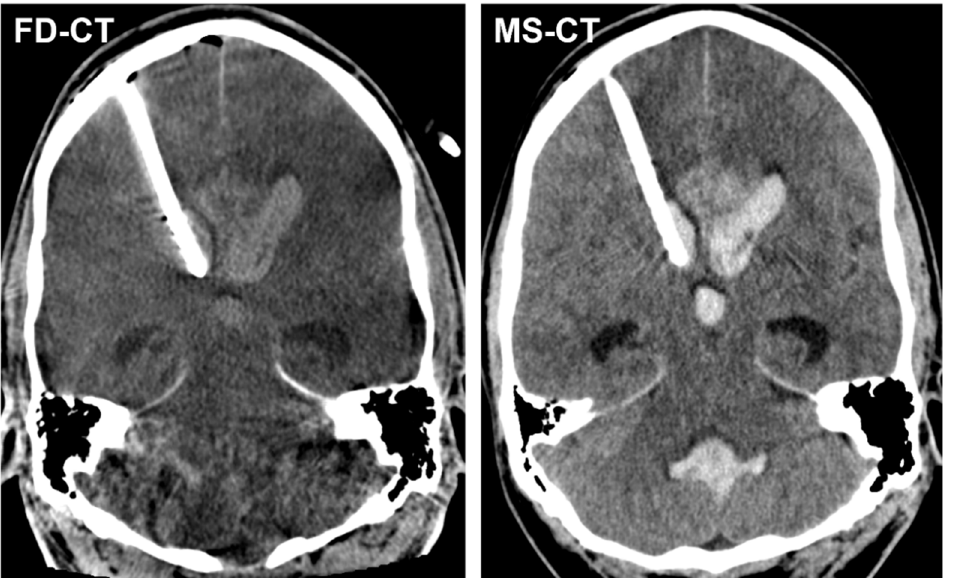
Figure 3. Exemplary FD-CT and MS-CT images of a patient with an endovascular treated, aneurysmal SAH and implanted external ventricular drain (EVD) because of acute obstructive hydrocephalus (AOH). Both FD-CT and MS-CT allow the precise determination of the intraventricular EVD position in the frontal horn of the right lateral ventricle as well as the delineation of the dilated ventricular